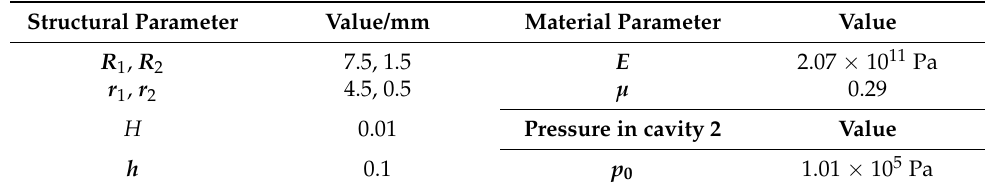
Table 1. Simulation parameters for the design of SPAS.